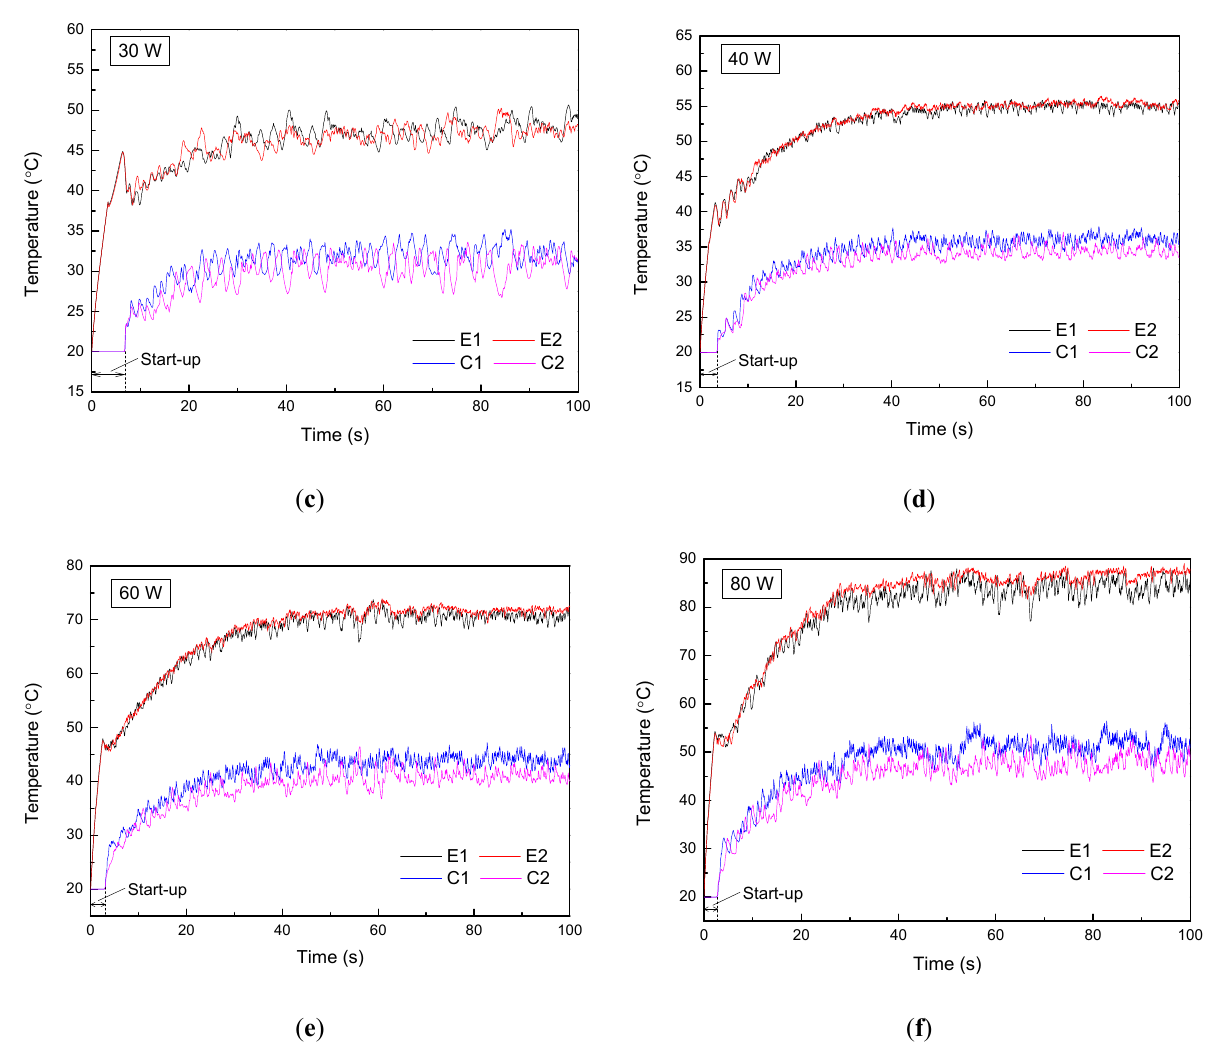
Figure 9. The wall temperature of the PHP with the adiabatic section of 180 mm at the heat input of ( a ) 20 W, ( b ) 25 W, ( c ) 30 W, ( d ) 40 W, ( e ) 60 W, and ( f ) 80 W.